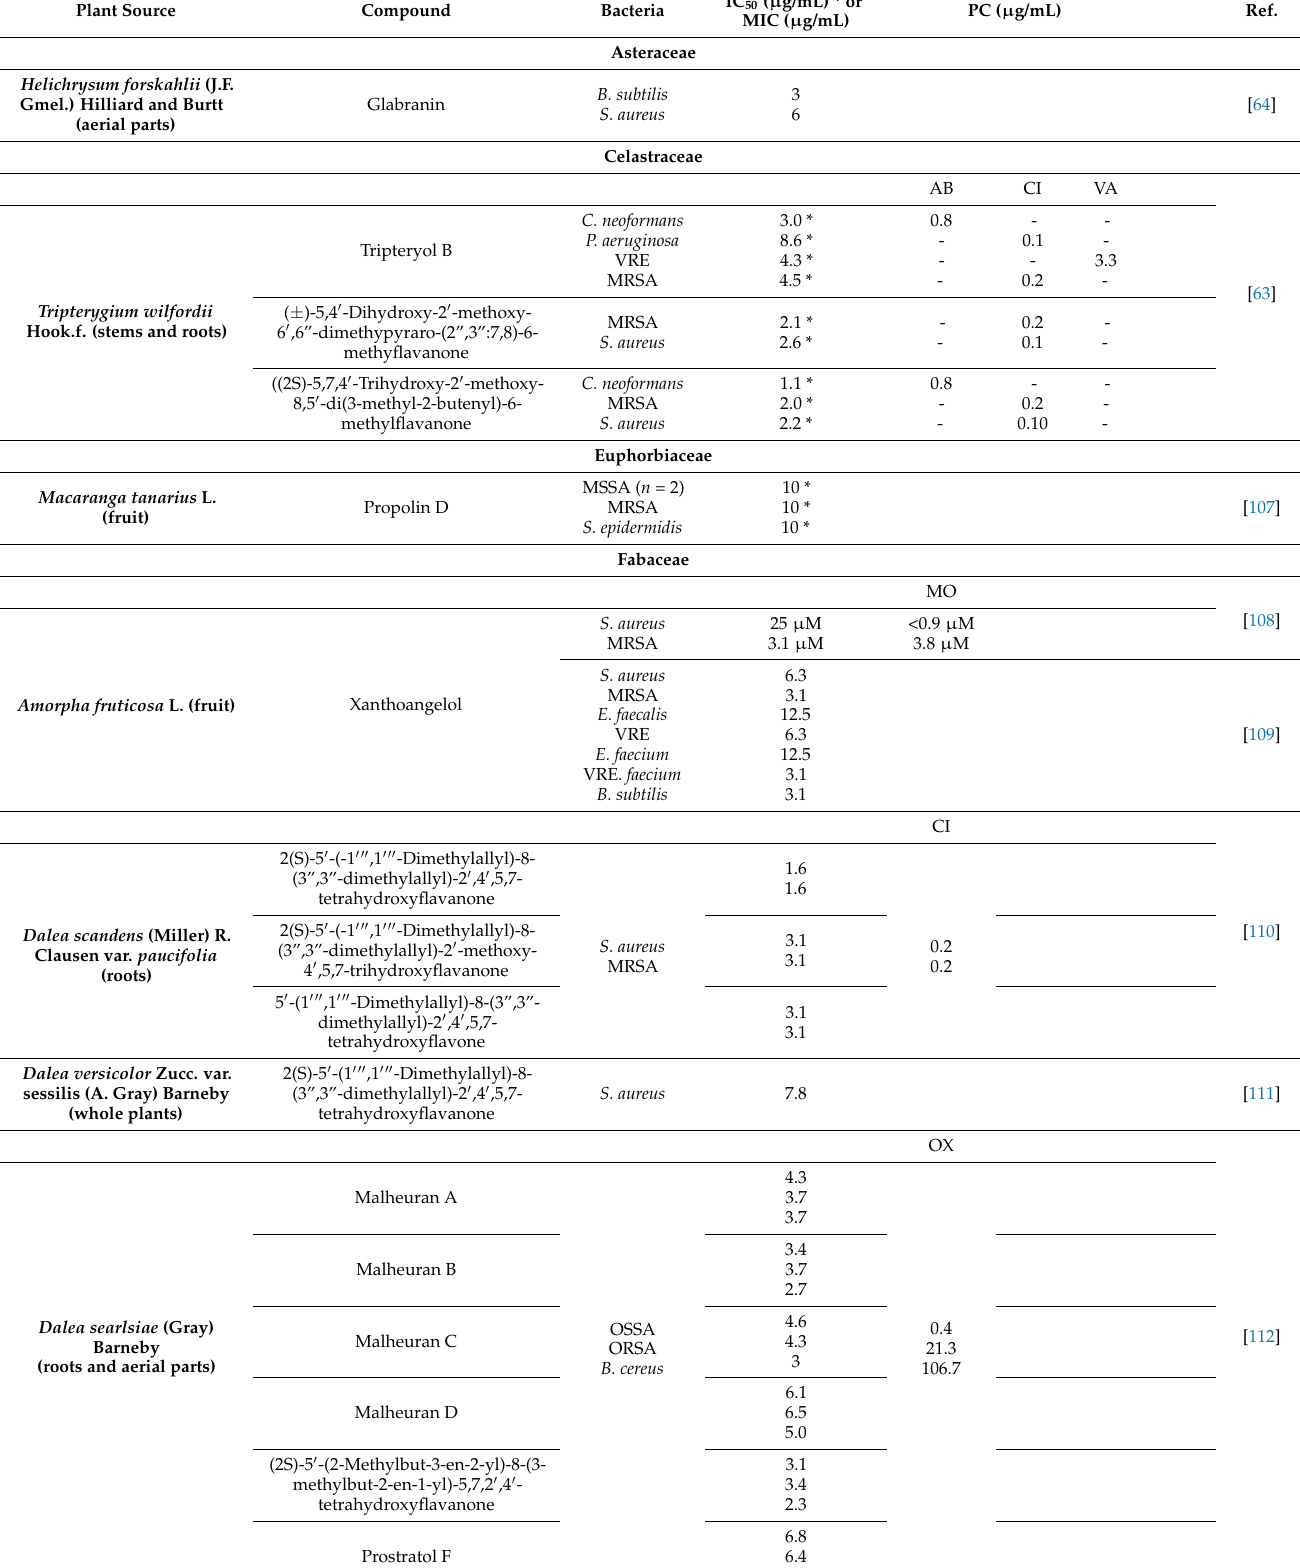
Table 1. Antibacterial activity of known prenylated flavonoids from natural